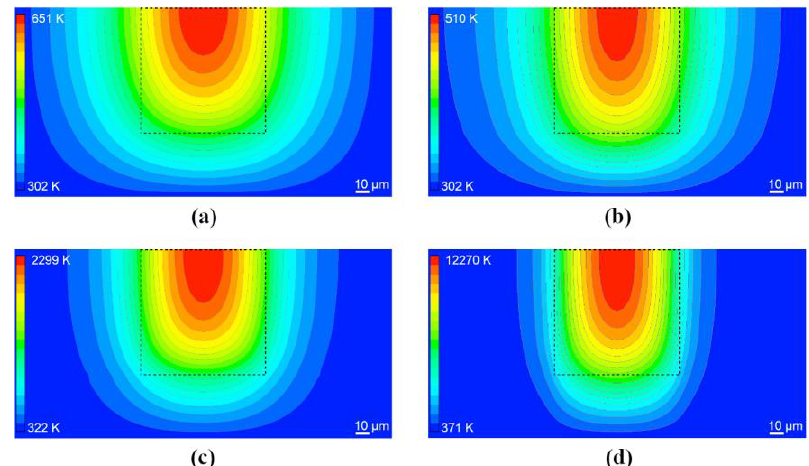
Figure 13. Time evolution of MLL temperature for different multilayer material pairs of WC/SiC, TiC/SiC, B 4 C/SiC and Be/SiC: ( a ) maximum temperature; ( b ) average temperature for a pulse train consisting of 20 pulses with 1 mJ energy per pulse.